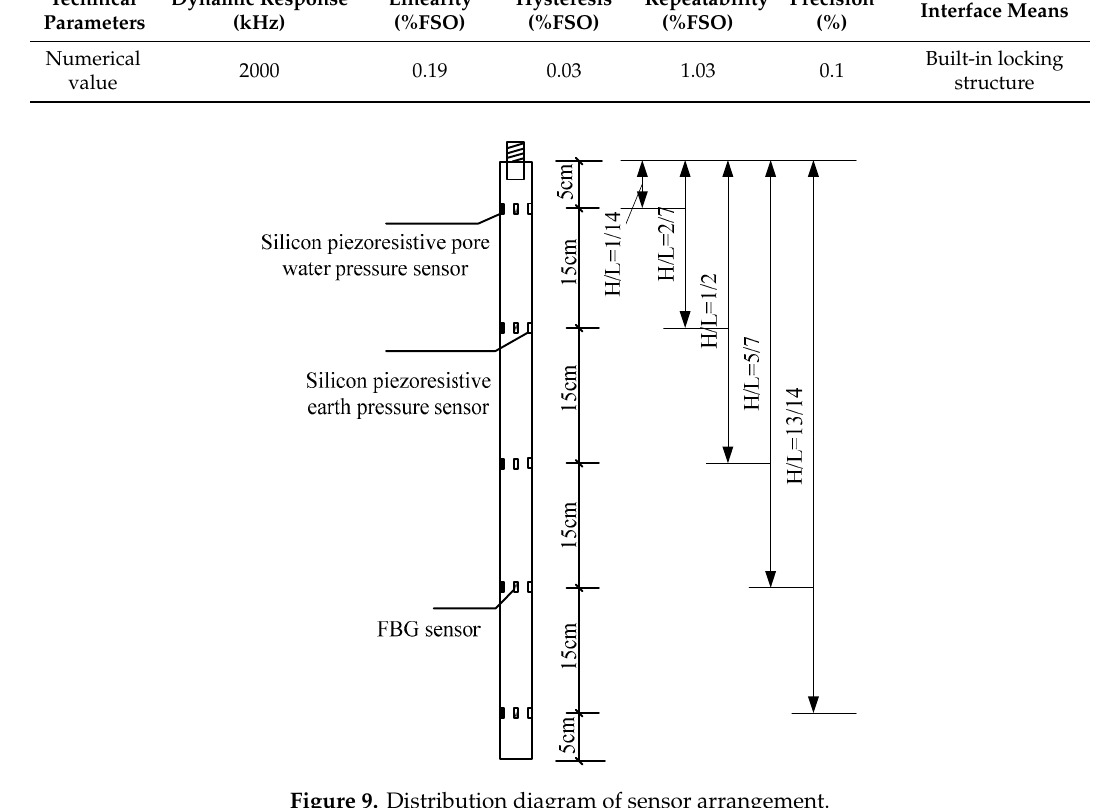
Figure 11. Test device. 5. Test Results and Analysis 5.1. Penetration Resistance The pile lateral resistance was calculated by measuring the pile force and pile end resistance respectively by the high-frequency pressure sensor on the top surface of the loading device and the miniature silicon piezoresistive-type earth pressure sensor mounted on the pile end. The curve of the three changes with the penetration depth can be drawn, as shown in Figure 12.